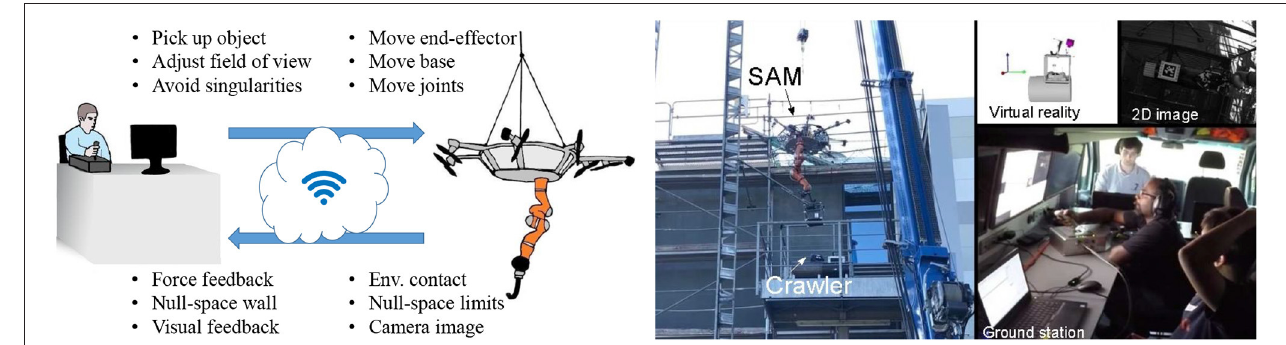
FIGURE 14 | (Left) Concept of the whole-body teleoperation approach for the SAM. [ © Coelho et al. (2021), CC BY 4.0]. (Right) Experimental setup, showing the robot, the ground station and the view provided to the user [ © 2020 IEEE. Reprinted, with permission, from Lee et al. (2020)].